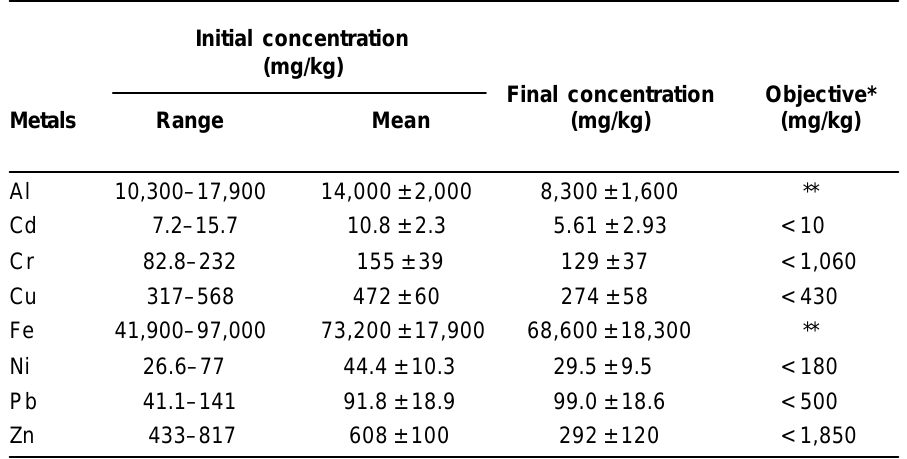
Metal Concentrations in Sludge Before and After Decontamination (Dewatered